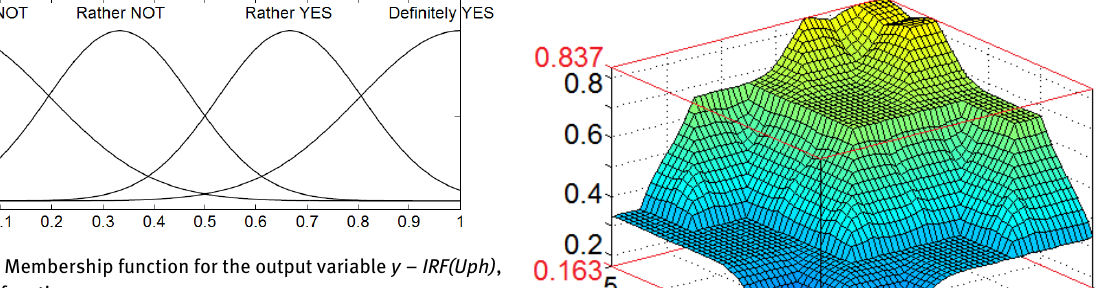
dle of maxima method, last of maxima method, centre of gravity method, bisector area method, weighted average method, height method, centre of sums method and cen- tre of largest area method.